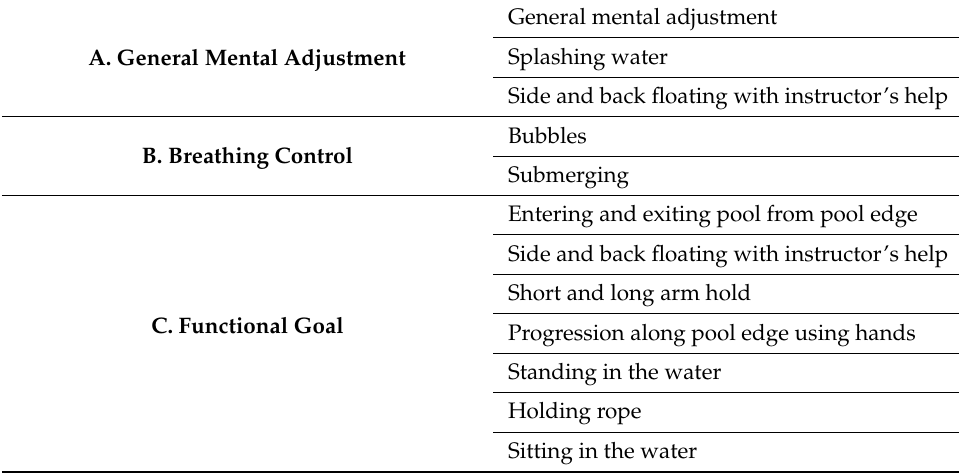
Table 2. WOTA 1 sections of testing